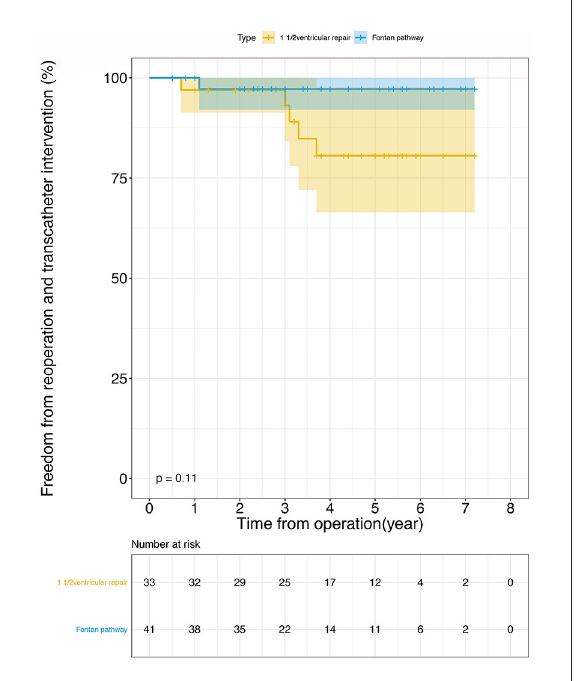
FIGURE2 The probability of survival using Kaplan-Meier analysis following operation: 1 1/2 ventricular repair (orange line), Fontan pathway (blue line). There was no statistical difference between the two groups (Log-rank p = 0.300). The confidence limits were indicated as a colored shaded area and the numbers at risk were shown in the box below the figure.